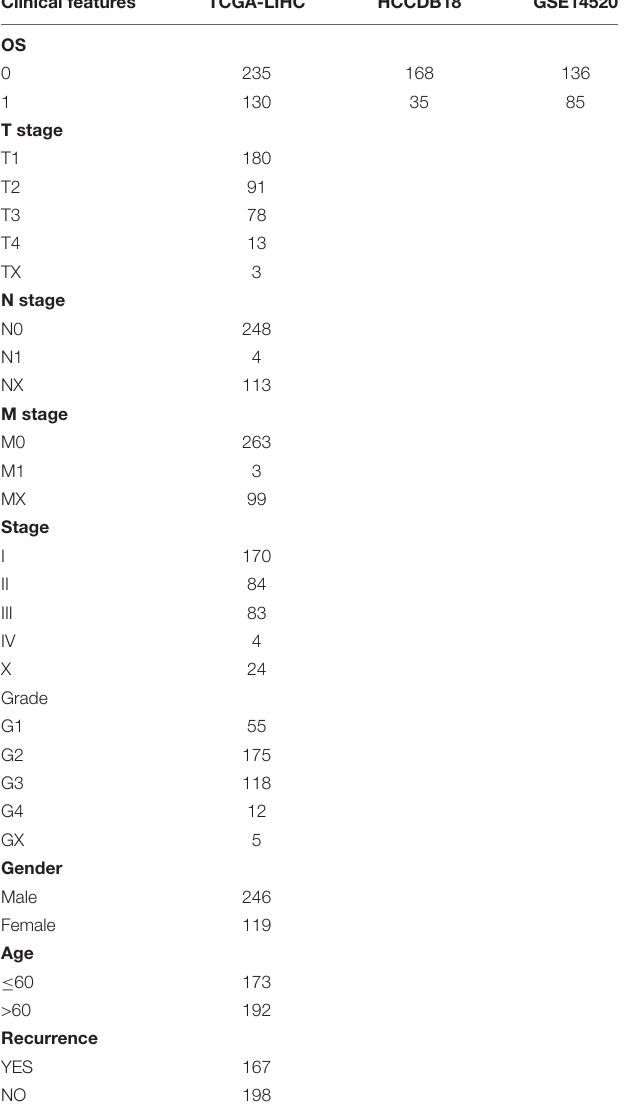
TABLE 2 | Samples with survival information. Clinical